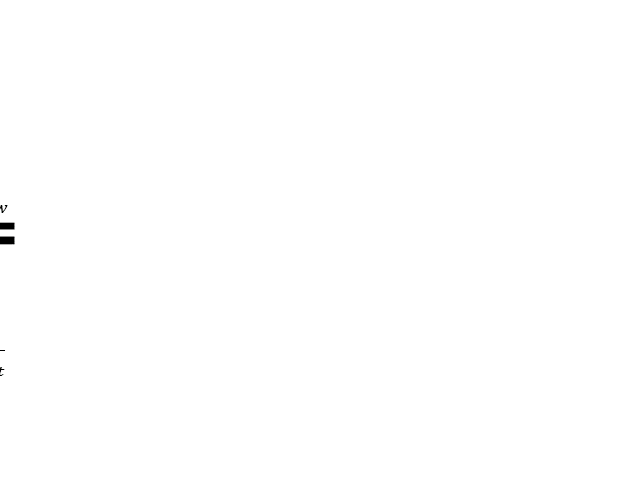
Figure 4. The 3R2C model of one dwelling in the apartment building. The temperature is calculated for a node in the indoor air ( T z ) and in the wall ( T w ). The outdoor temperature ( T ext ) is derived from a weather profile in Belgium [47]. The heat flow from solar gains ( ˙ Q sol ), indoor heat gains ( ˙ Q int ), and the underfloor heating ( ˙ Q em ) are divided over the zone and wall node.